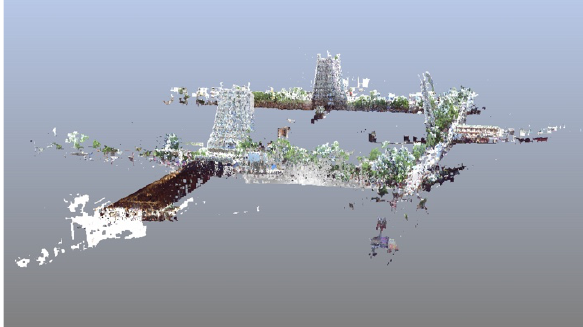
Figure 1. Pointcloud showing Pudu Mandapam (in the foreground) in relation to W, N and E Gopura of the